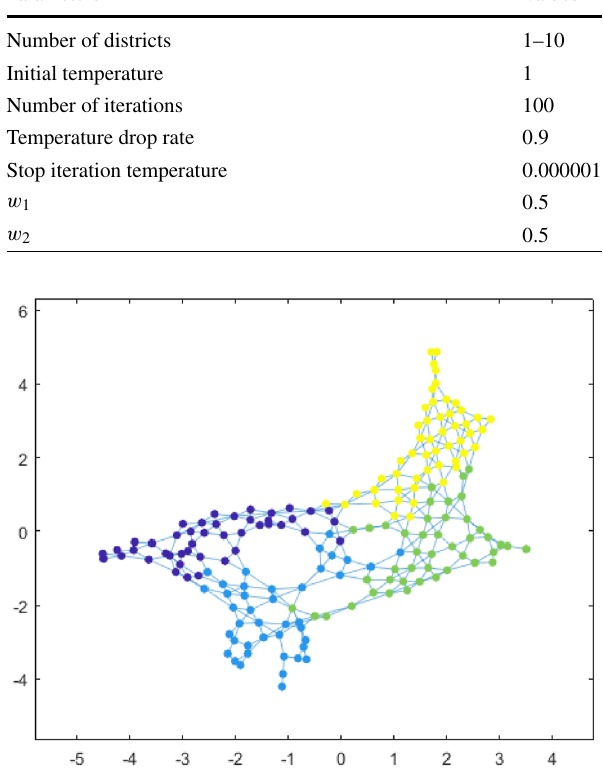
the algorithm is illustrated with different cases by choosing small instances and real scenes, and 10 different scenarios are generated under each of the two numbers of road networks. Table 2 lists the parameter settings of the experiments. The proposed algorithm (SCRn-SA) of this paper is com- pared with the single algorithm-spectral clustering algorithm [39] based on road network (SCRn), simulated annealing